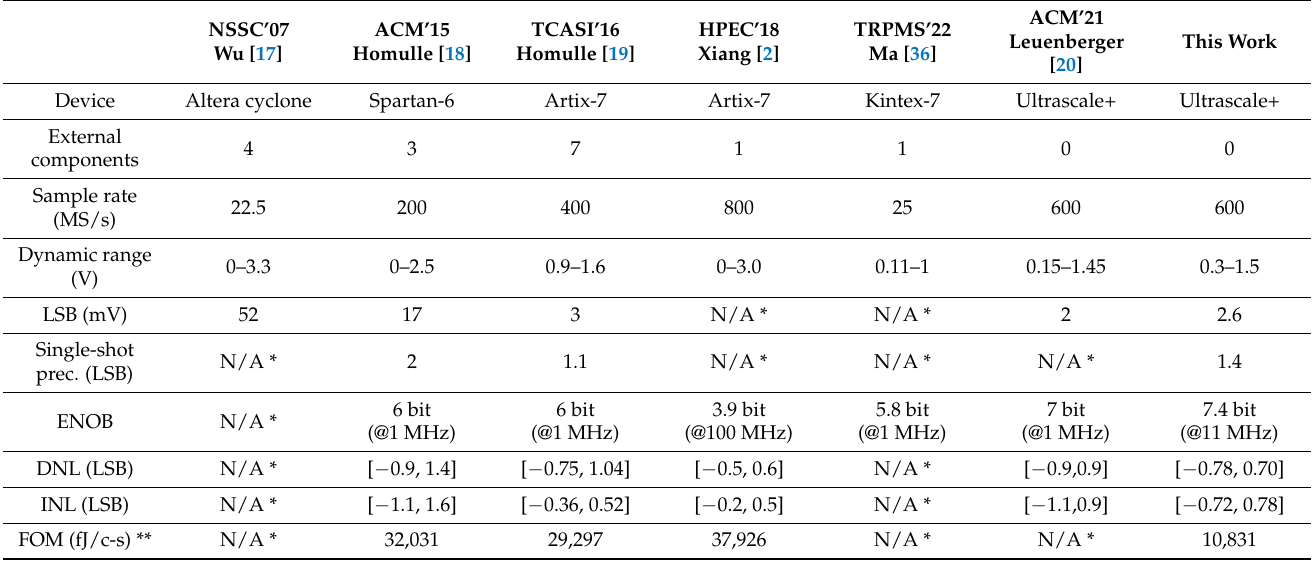
Table 4. Performance summary and comparison of state-of-the-art FPGA-based